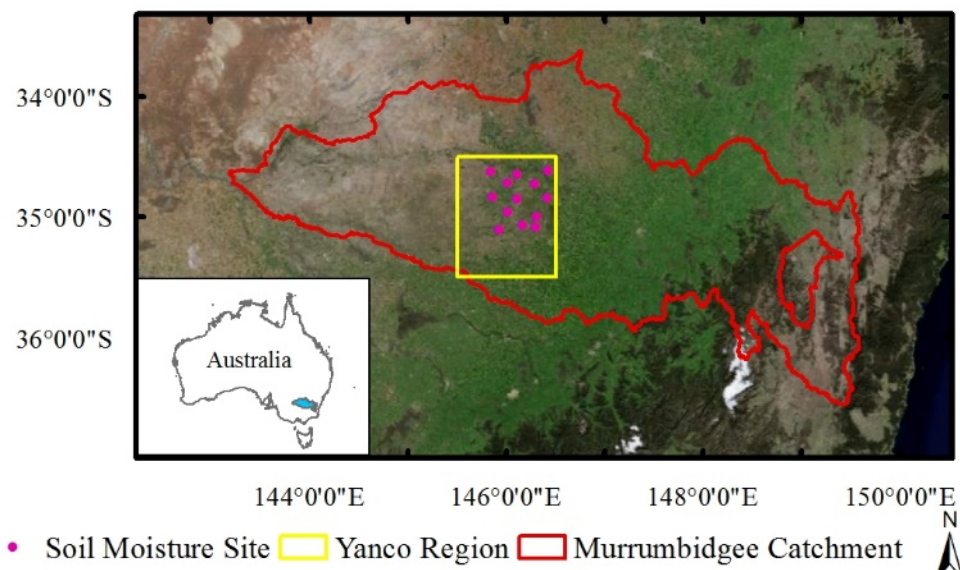
Figure 3. Study area and the spatial distribution of the in situ soil moisture sites.